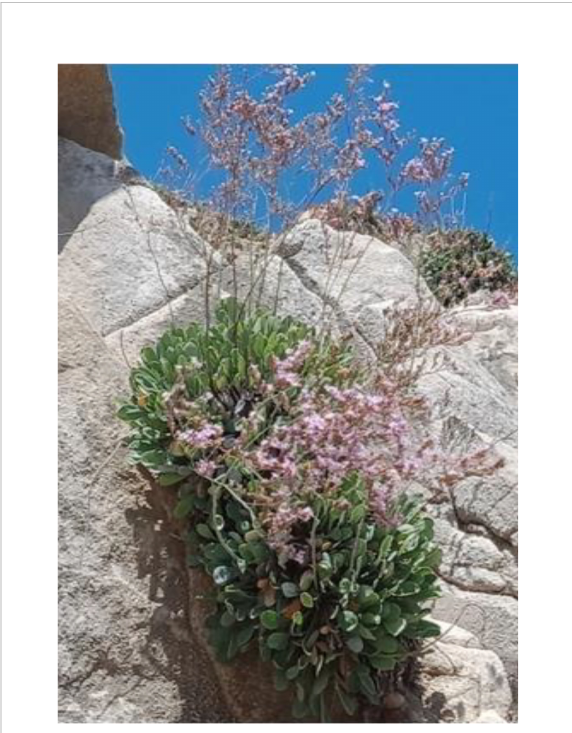
FIGURE 1 General aspects of Limonium spathulatum, Tabarka rocky coast